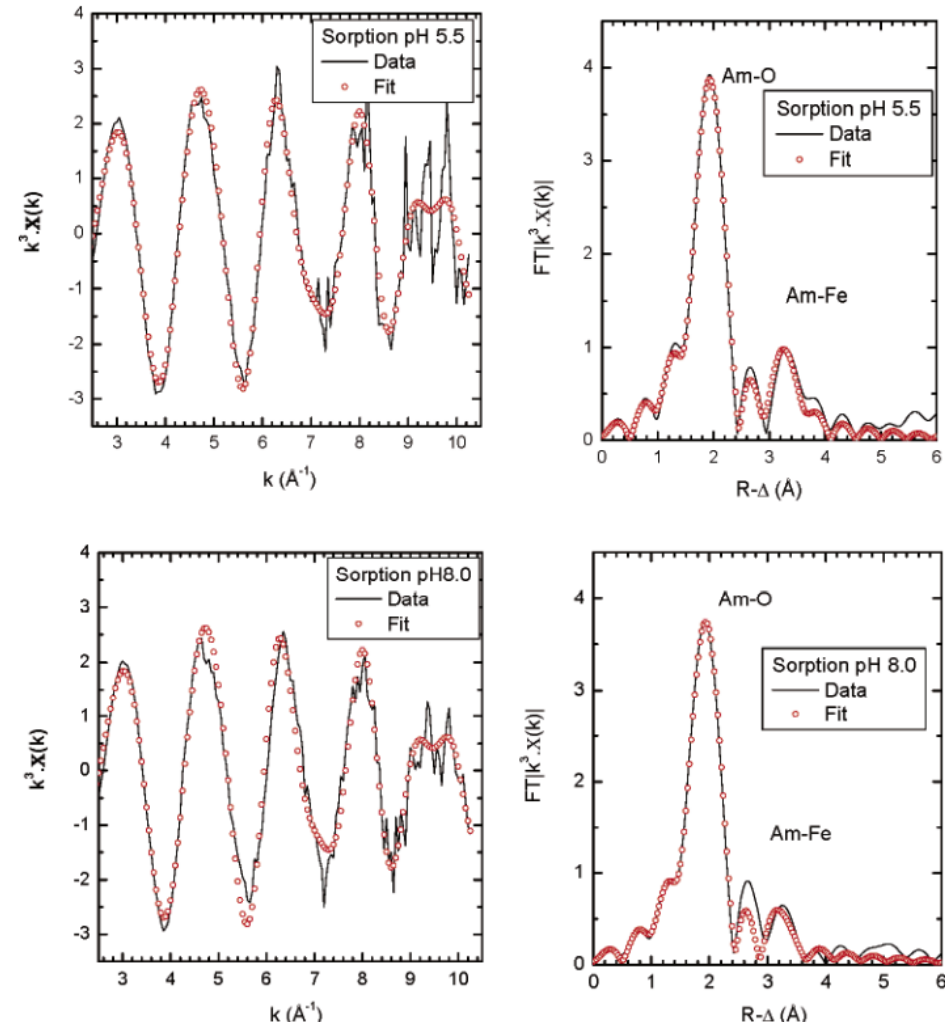
Figure 7. Am sorption onto ferrihydrite at pH 5.5 and 8.0. ( Left ): k 3 ‒ weighted Am L3 edge experimental EXAFS and back transformed R ‒ space fit results. ( Right ): corresponding Fourier transformed spectra. Experimental data are lines and fit experimental EXAFS and back transformed R–space fit results. ( Right ): corresponding Fourier data are circles . Reprinted with permission from ref. [43]. Copyright 2021 Amrican Chemical Society. transformed spectra. Experimental data are lines and fit data are circles. Reprinted with permission from ref. [43]. Copyright 2021 Amrican Chemical